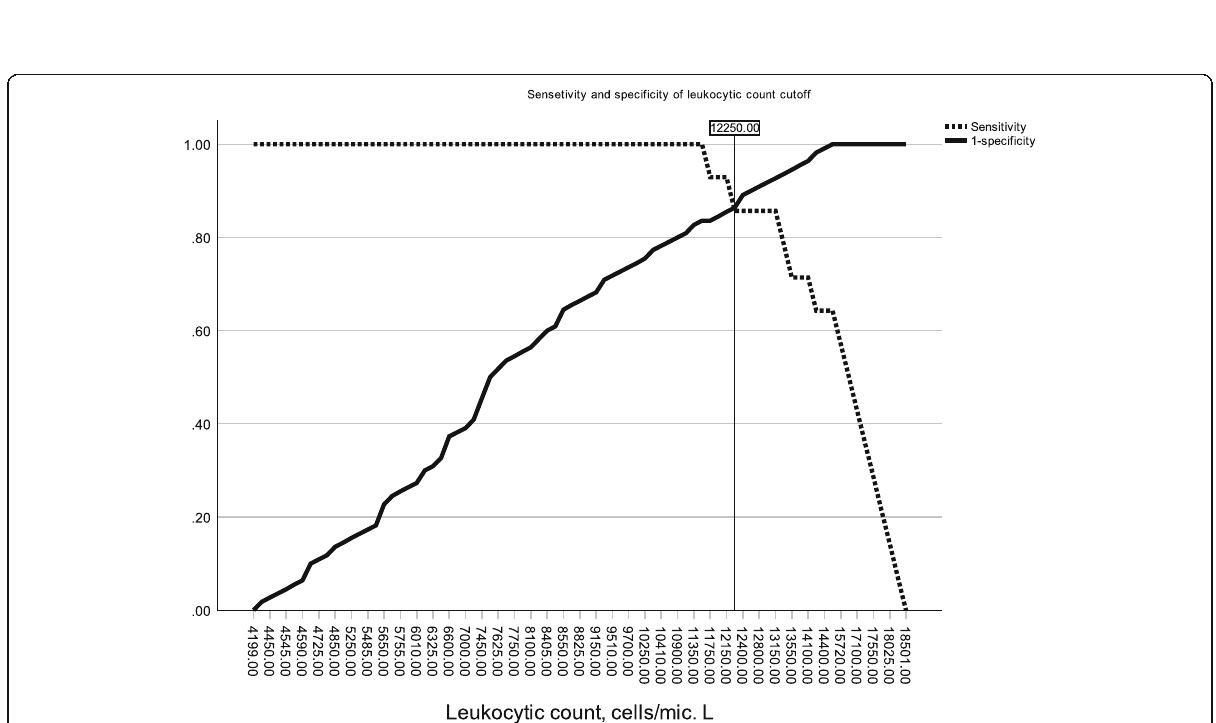
Fig. 2 Cutoff value of leukocytic count for detection of bacteria in the aspirate of infarct related artery. It gives sensitivity of 85.7% and specificity of